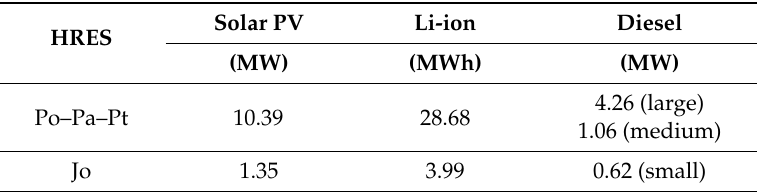
Figure 7. Optimum sizes and LCOE of different interconnection configurations normalized with respect to the highest value. Table 10. Details about the least-cost Po–Pa–Pt Jo configuration.